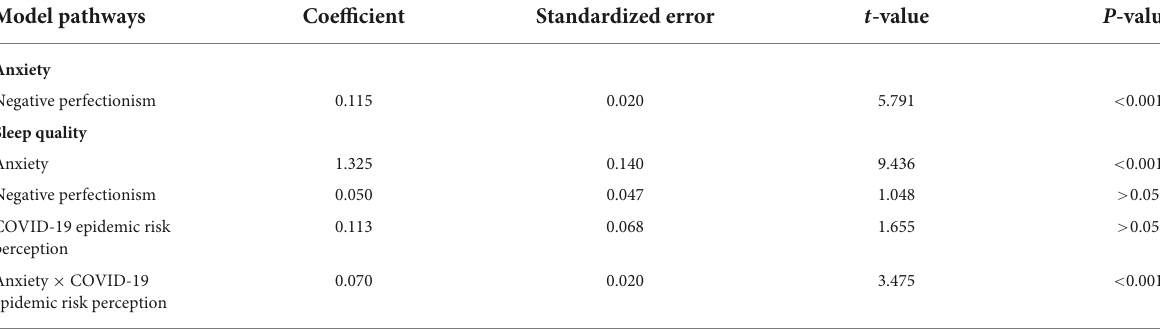
TABLE 3 Mediating effects of anxiety and moderating effects of epidemic risk